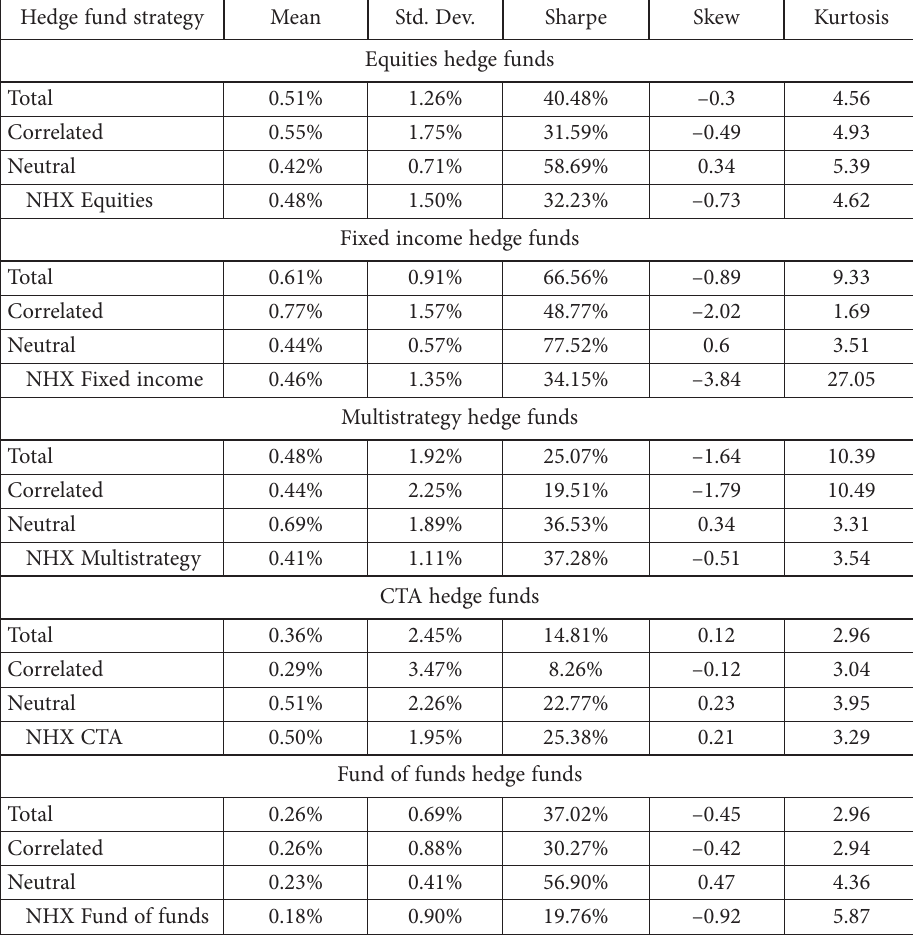
Table 3. Summary statistics of NHX hedge fund portfolios